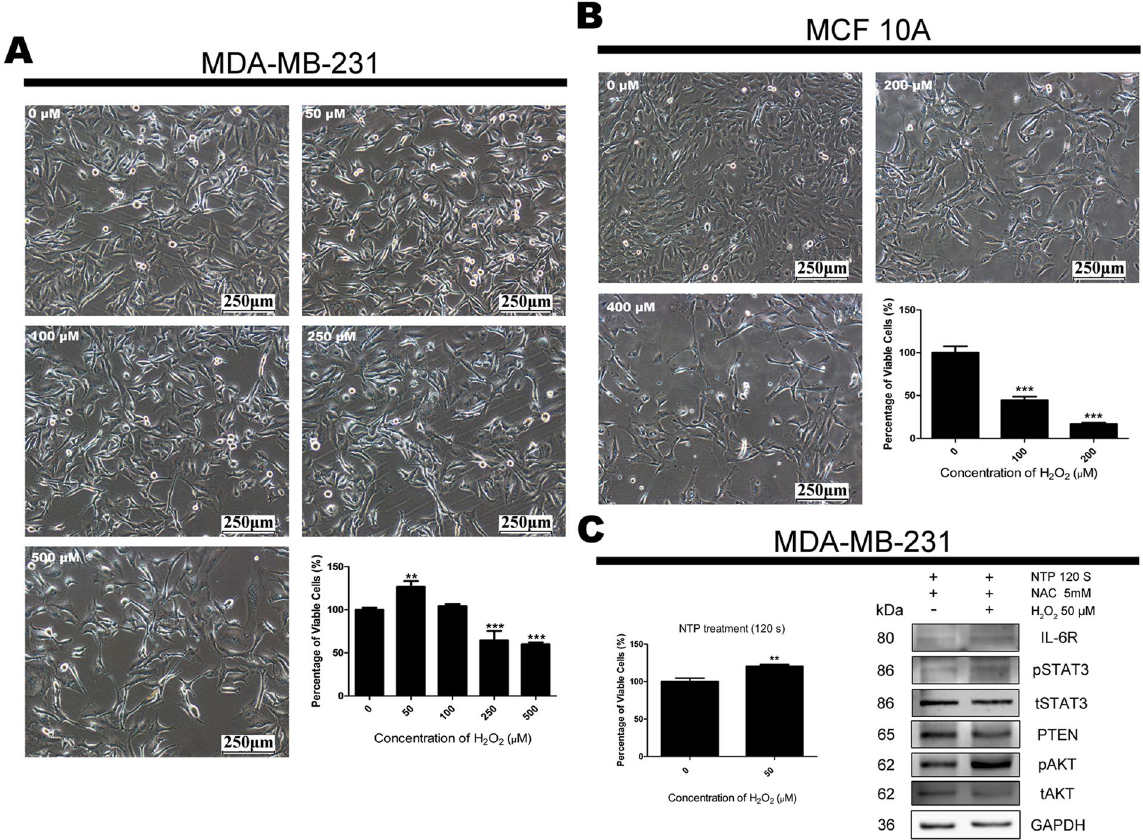
Figure 5. Effects of H 2 O 2 on the proliferation of MDA-MB-231 and MCF10A cells. MCF10A ( A ) and MDA-MB-231 ( B ) cells were incubated with multi-dose H 2 O 2 . Forty-eight hours later, cell images were captured with 100 × magnification and cell numbers of each dish were counted by an automatic analyzer CountStar. All experiments were replicated a minimum of three times. Data are presented as means ± S.D. and statistical